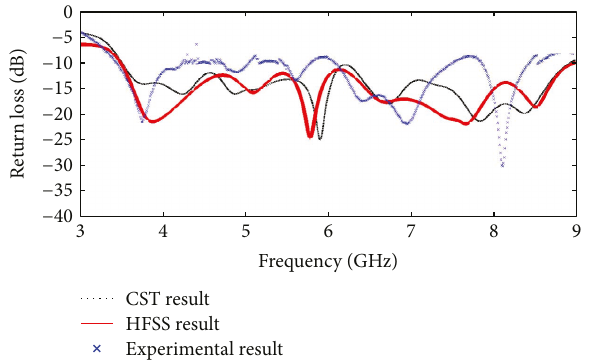
Figure 15: Comparison between simulated and experimental return loss result of our array antennas.